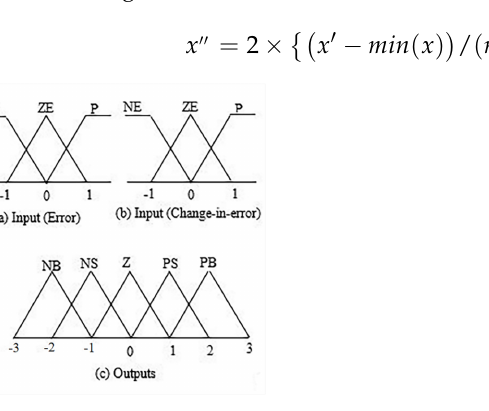
Figure 4. Fuzzy membership functions. Table 2. Fuzzy linguistic rule-base.